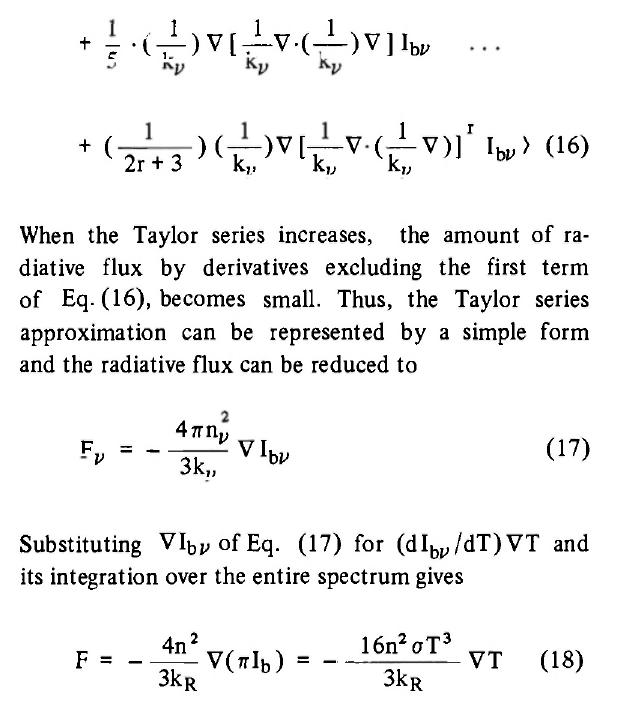
Fig. 2. Geometrical model for analysis of the radiative flux of semitransparent